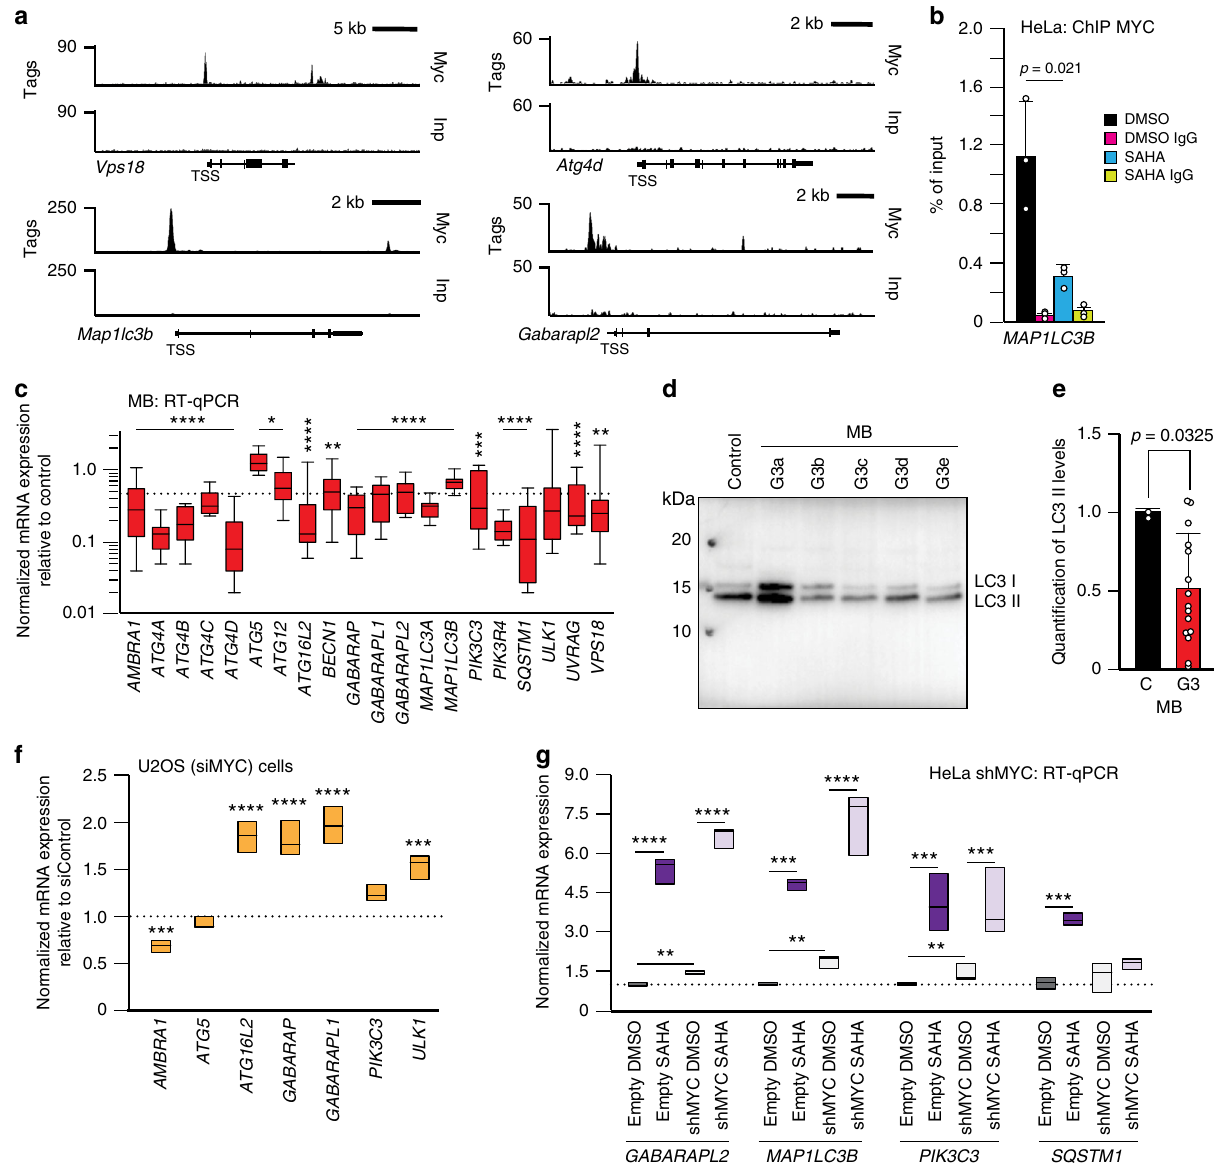
Fig. 6 MYC represses autophagy. a ChIP-seq analysis for Myc binding to the promoters of Vps18, Map1lc3b, Atg4d , and Gaparapl2 performed in mouse group 3 medulloblastoma tumorspheres overexpressing Myc , MB ( Trp53 − / − overexpressing Myc ) ( n = 3 independent experiments). b ChIP analyses of the MAP1LC3B promoter using anti-MYC antibody performed in HeLa cells treated with SAHA (20 μ M for 24 h) or DMSO ( n = 3 biologically independent samples). c RT-qPCR of autophagy genes in tumorspheres Trp53 − / − overexpressing Myc (MB), ( n = 10 biologically independent samples). d Comparative LC3 immunoblots of tumorspheres Trp53 − / − overexpressing Myc and control Trp53 − / − cells. e Quanti fi cation of the LC3II/LC3I ratio normalized to Coomassie stained immunoblots, used as loading control. C = Control ( Trp53 − / − ) cells ( n = 3 biologically independent samples); G3 = tumorspheres Trp53 − / − overexpressing Myc ( n = 15 biologically independent samples). f Expression levels of several autophagic genes in U2OS cells with silenced MYC expression. g RT-qPCR of GABARAPL2 , MAP1LC3B , PIK3C3 and SQSTM1 was performed in HeLa cells silenced for MYC (shMYC) ( n = 3 biologically independent samples) and treated with SAHA (8 μ M for 24 h). Boxes represent the mean value and bar inside the box represents median value; upper bar represents maximum of distribution; lower bar represents minimum of distribution (95% con fi dence level). Graphs are presented as mean ± SD. Statistical analysis was performed using the Student t -test. * p < 0.05, ** p < 0.01, *** p < 0.001, **** p <